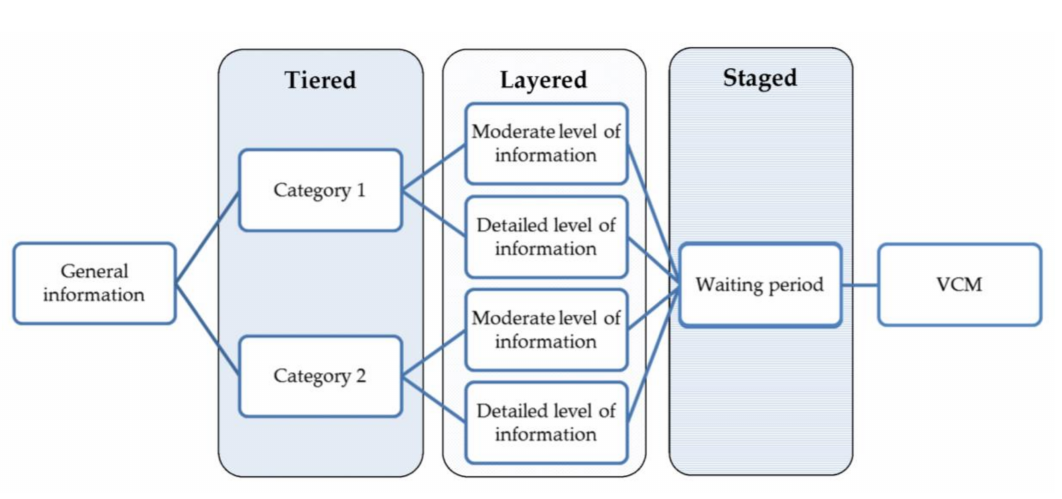
Figure 1. Framework to guide the development of Patient Decision Aids (PDAs) within the tiered layered staged informed consent model. VCM: value clarification